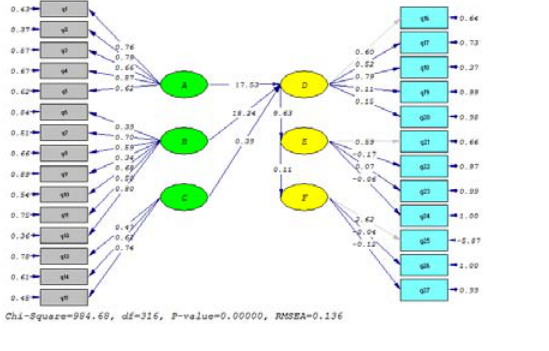
Fig. 2. Personal characteristics of the participants